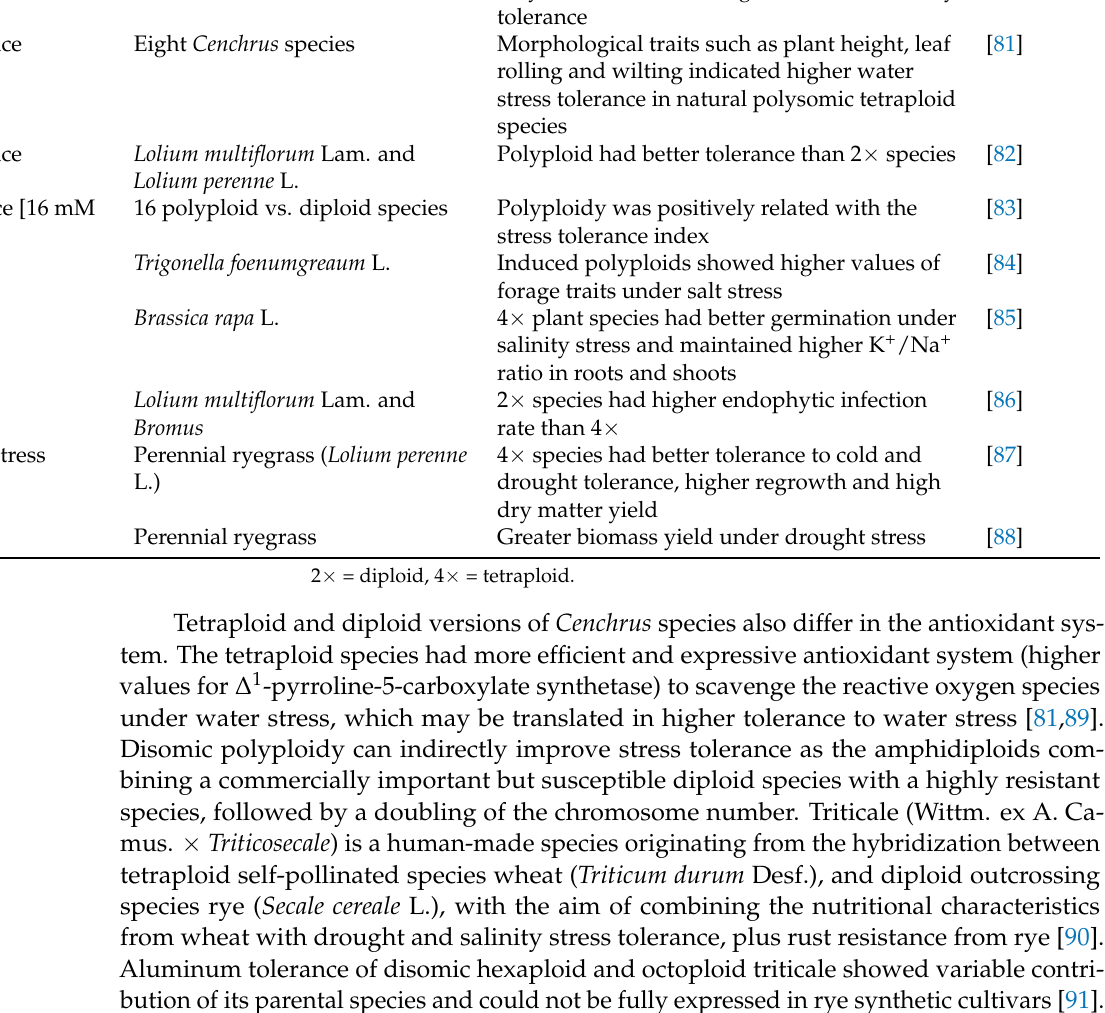
Table 4. Response of natural and induced polyploidy to various abiotic stress conditions and endophytic fungi interactions. Stress Species Resistance Reference Salinity Chloris gayana L. (Rhodes grass) Wild genetic diversity in tetraploid species may be useful for making selection for salinity Water stress tolerance Eight Cenchrus